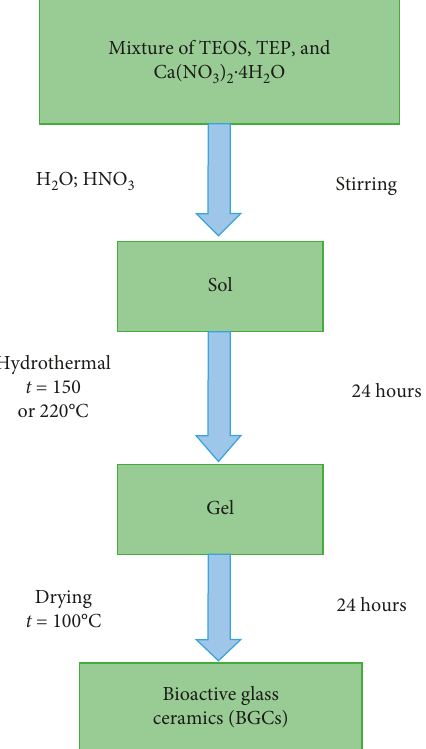
Scheme 1: Schematic of the hydrothermal process for synthesis of bioactive glass